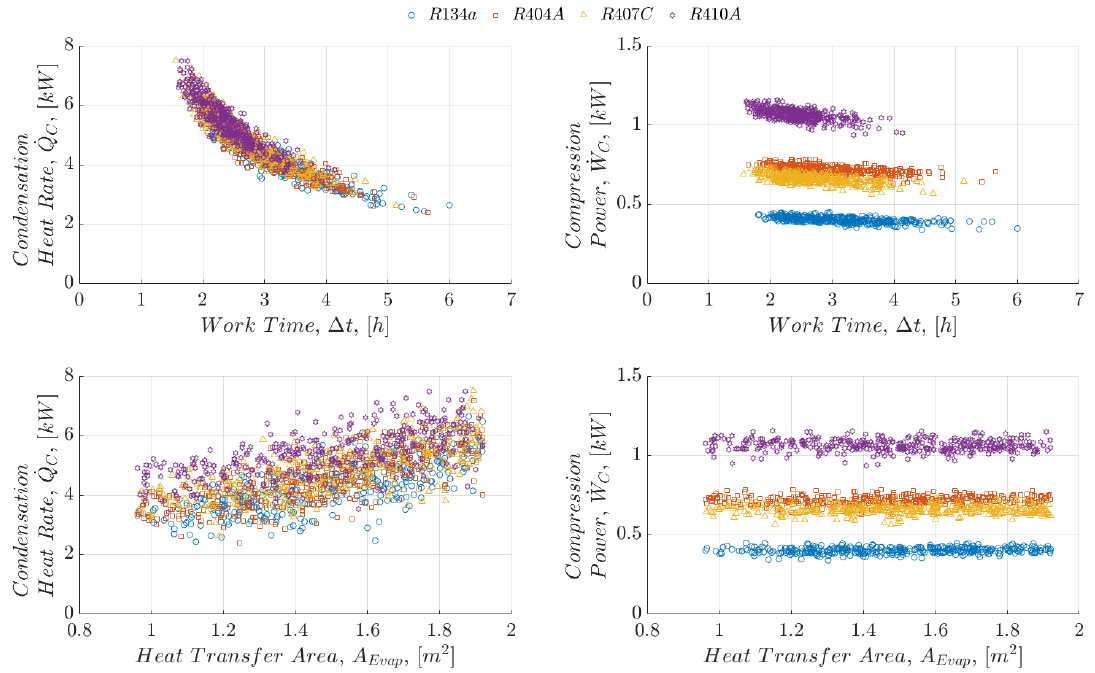
Figure 25. Performance of the optimized DXSAHP system based on the energy exchange.